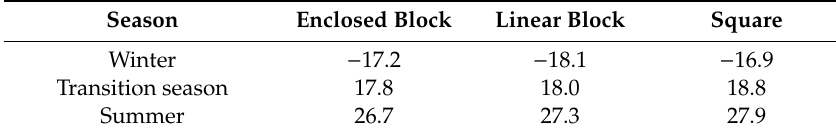
Table 5. Average air temperature ( ◦ C) of each space form.